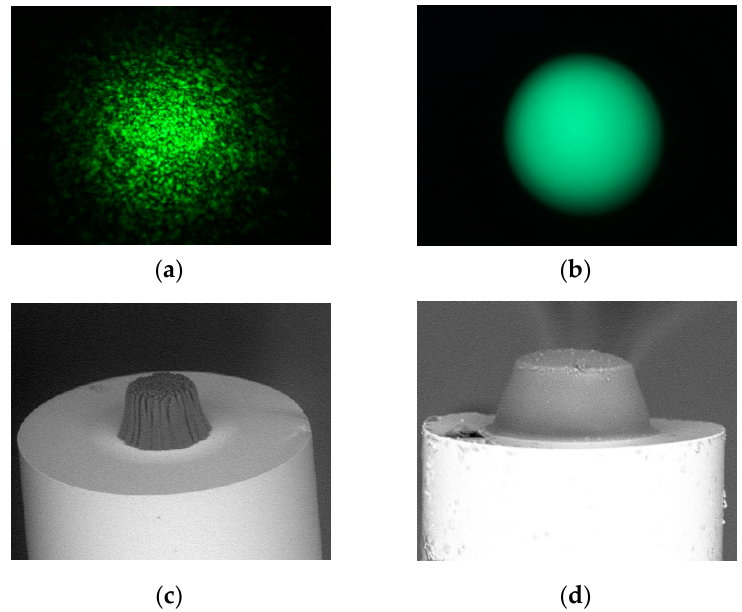
Figure 2. CCD images of the intensity patterns of multi-mode fibers (MMF) with a 62.5 µm core illuminated by VIS: ( a ) laser; ( b ) LED, SEM images of microtips manufactured with mentioned pentaerythritol triacrylate (PETA)-based mixture and prepared with a respective light source, optical power, and exposure time; ( c ) laser , Eosin Y/amine photo-initiating system (PIS), P = 20 µW, t = 30 s; ( d ) LED , Eosin Y/amine PIS, P = 20 µW, t = 60 s.